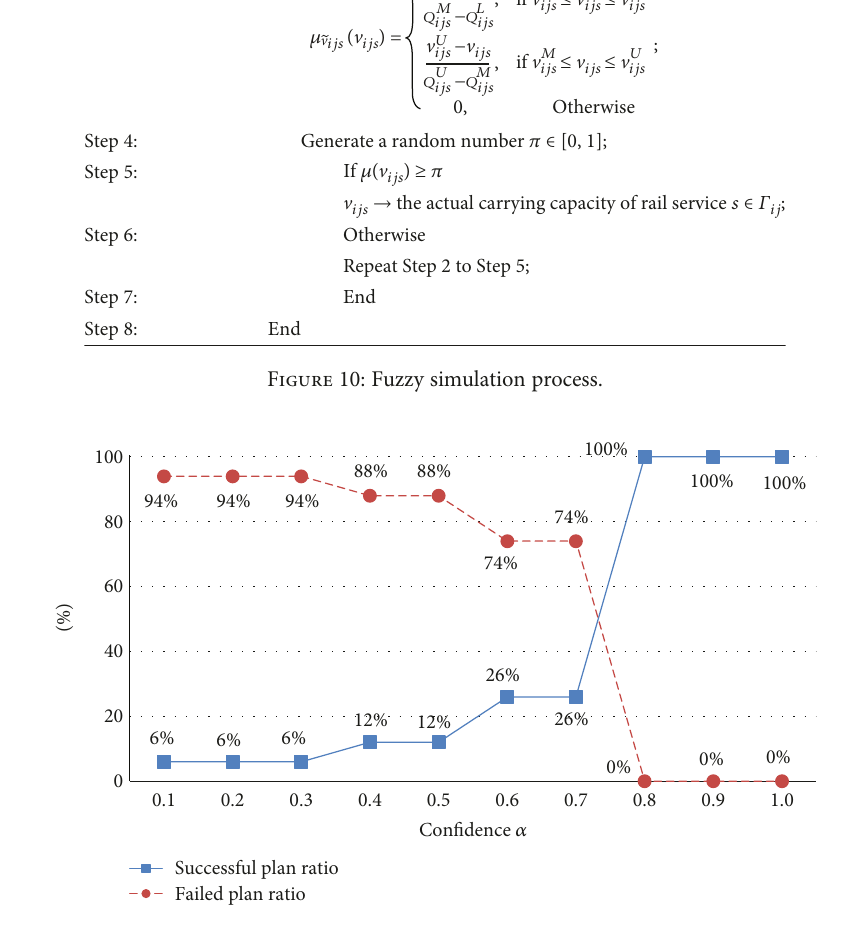
Figure 11: Fuzzy simulation result regarding con fi dence α